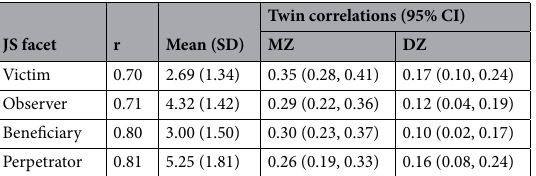
Table 1. Descriptive statistics and twin correlations. r = correlation between the two items for each facet.